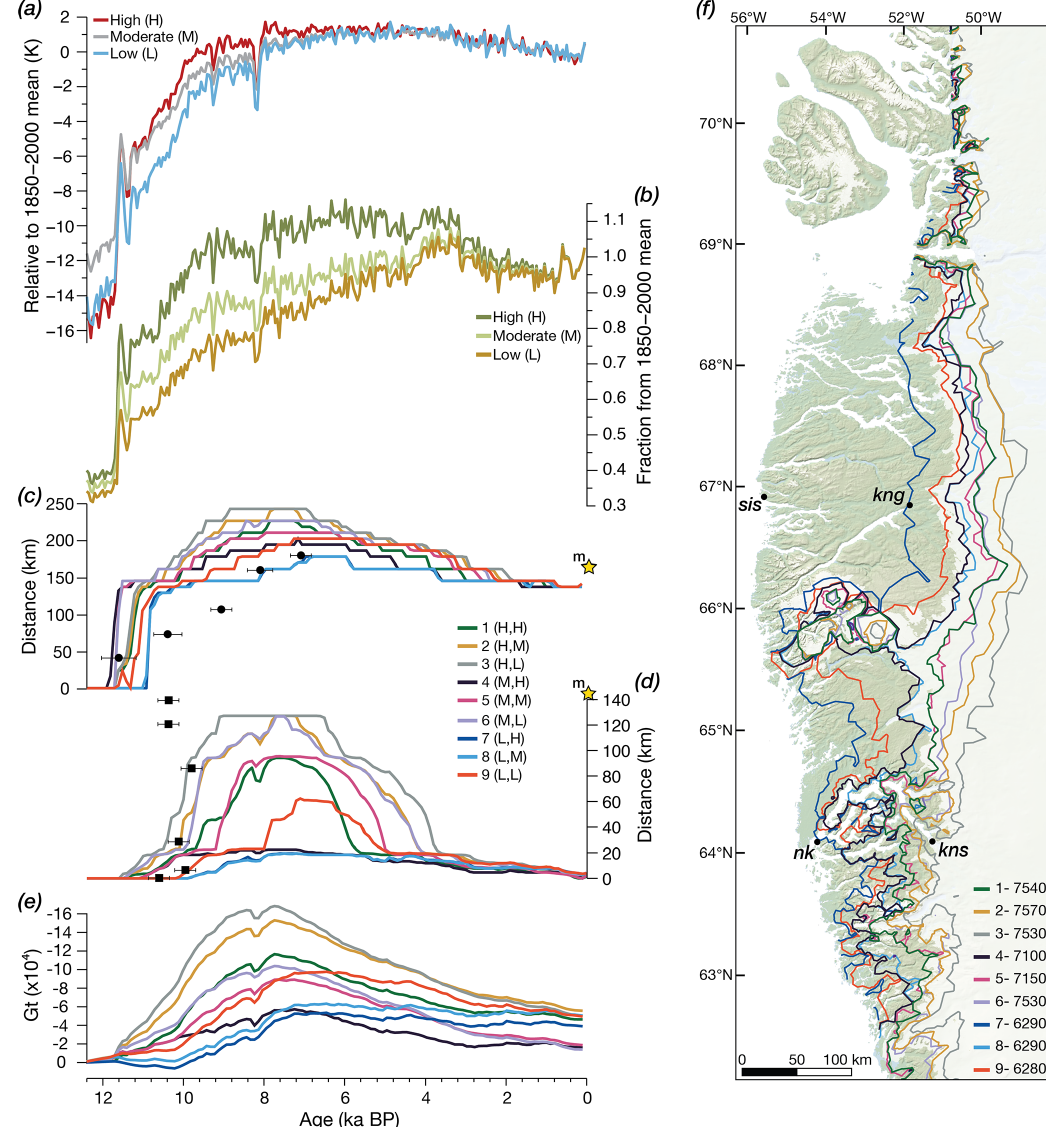
Figure 18. (a) Area-averaged mean annual temperature using three different reconstructions across the ISSM model domain (Badgeley et al., 2020; Briner et al., 2020). (b) Same as (a) , but for mean annual precipitation (Badgeley et al., 2020; Briner et al., 2020). (c) Simulated margin position in the Sisimiut (sis)–Kangerlussuaq (kng) region through the Holocene compared to independent observations of ice-margin position based on dated moraines (black dots; 1 σ age uncertainty; Young et al., 2020a) and the modern ice margin (“m”– orange star; modified from Briner et al., 2020). The y axis is the distance measured from the coast. Letters next to each simulation mark the temperature and precipitation reconstructions from panels (a) and (b) . (d) Simulated margin position in the Nuuk (nk)–Kangiata Nunaata Sermia (kns) region through the Holocene compared to independent observations of ice-margin position based on deglaciation ages (see Fig. 1 for age constraints and up-fjord transect). (e) Simulated ice mass through the Holocene across the model domain (Briner et al., 2020); note that the y axis is reversed. (f) Simulated lateral ice-margin extent at the time of minimum ice mass in each model run. The year (BP) of the ice-mass minimum in each model run is listed in the